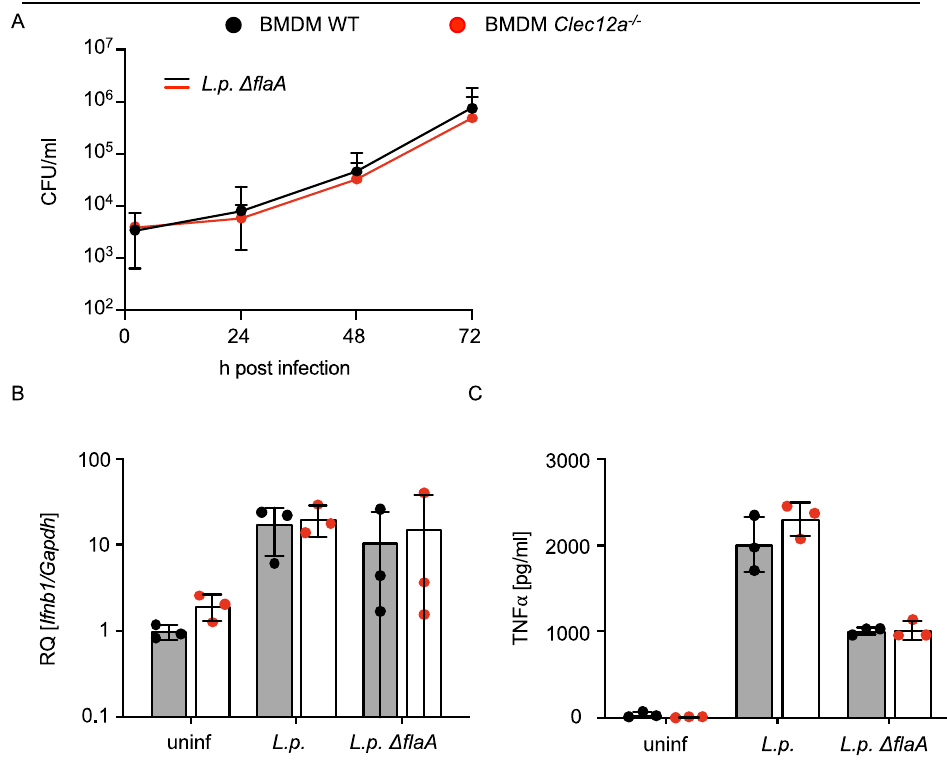
Figure 2. Replication of Legionella in murine BMDMs as well as type I IFN responses and TNF α production are not influenced by CLEC12A. ( A ) WT and Clec12a − / − BMDMs were infected with L. pneumophila Δ flaA at MOI 0.1, and replication was assessed by evaluating CFUs in the cells and supernatants after 2, 24, 48 and 72 h. ( B , C ) WT and Clec12a − / − BMDMs were infected with L. pneumophila JR32 (“ L.p .”) or Δ flaA at MOI 10, and the expression of Ifnb1 was evaluated at 8 h after infection by qRT-PCR. TNF ⍺ levels were quantified from supernatants after 18 h. All data represent the mean ± SD of 3 independent experiments carried out in triplicate. Differences were assessed using multiple paired t -tests. Comparisons with p < 0.05 were considered significant.